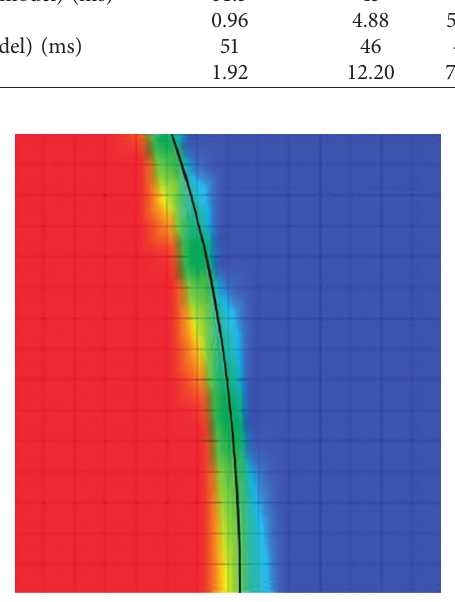
Figure 16: Sharpness of the interface reconstruction. Red region: bubble; blue region: liquid; transition region: interface; bold black line: actual